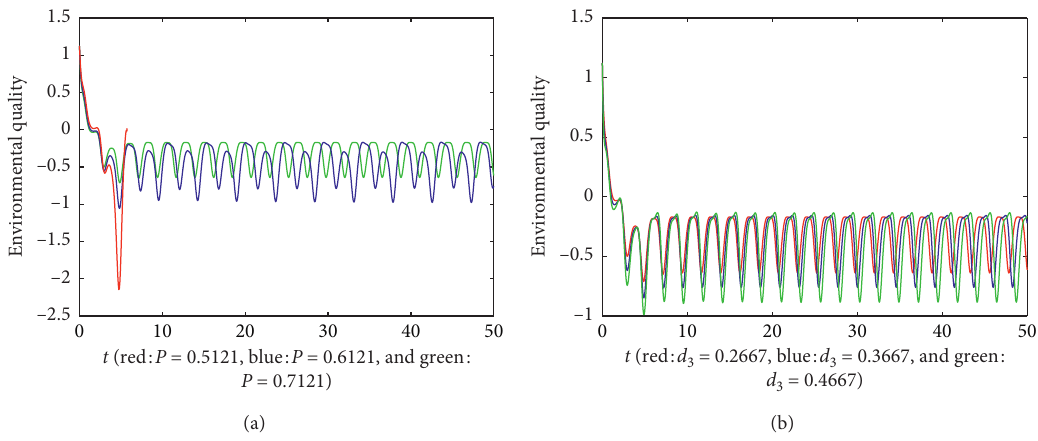
Figure 10: The different parameters P and d